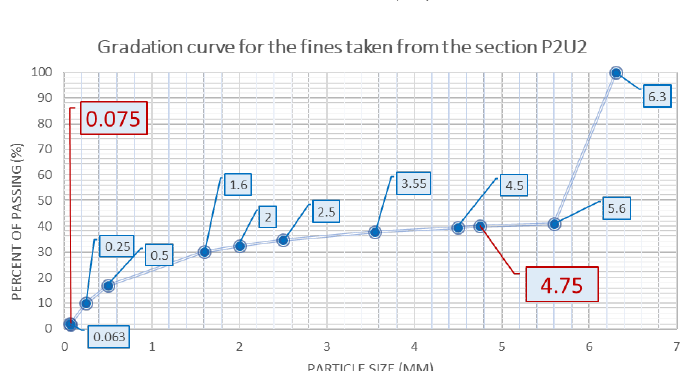
Figure 7. Preliminary interpretation of raw data from 2 GHz air-coupled antenna for section P2U1 at stage 4 with longitu- dinal orientation ( a ) raw data (only dewow filter is applied) ( b ) initial interface picking based on in situ visual observations and the ground truth data. In comparison with the air-coupled antennas, ground-coupled antennas, particu- larly, with low frequencies provide lower resolutions to determine surface and interface